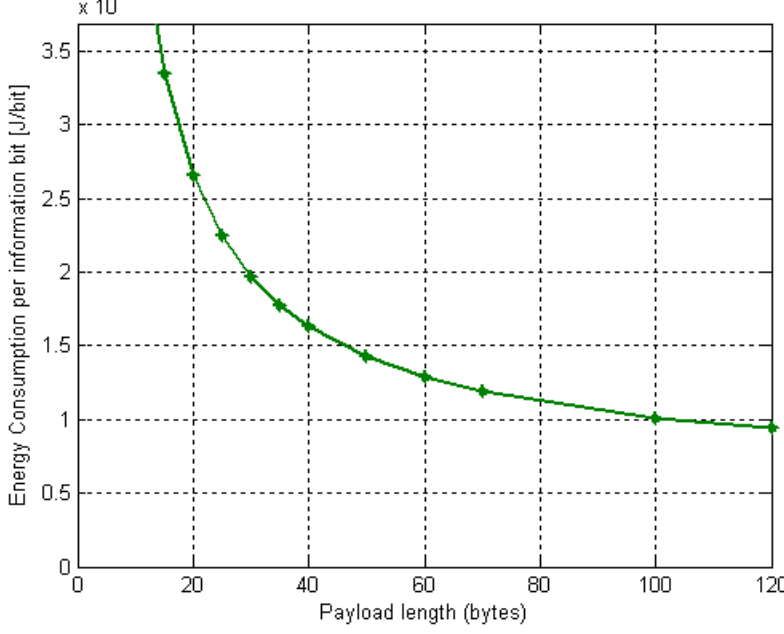
Figure 7. Energy consumption per information bit of DQ MAC protocol for